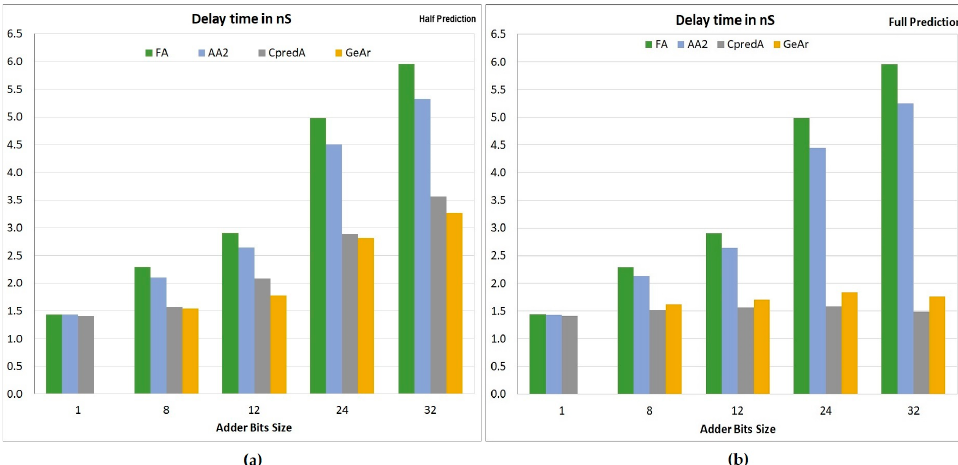
Figure 9. Adders delay time in ( a ) half prediction, ( b ) full prediction configurations.